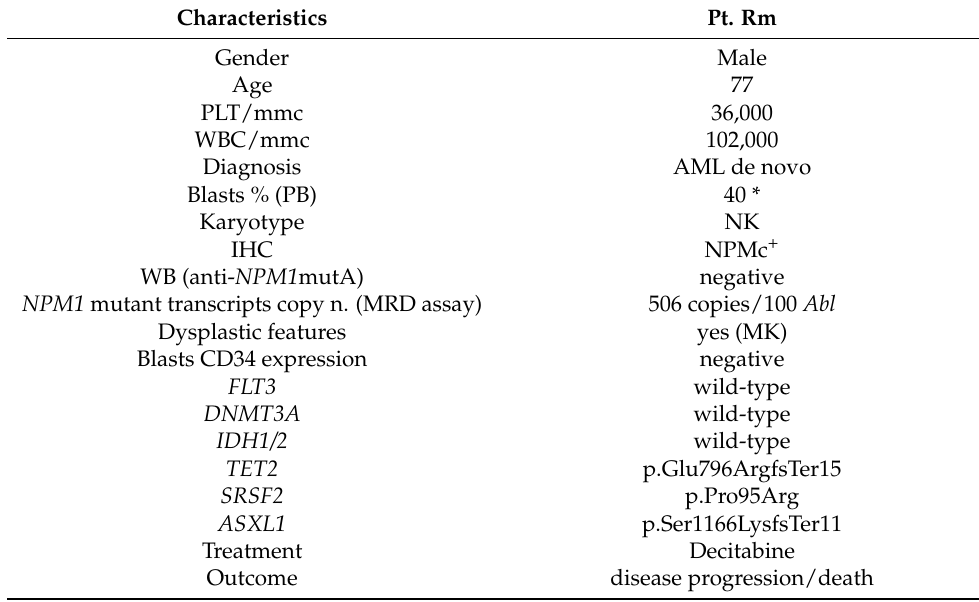
Table 1. Biological and clinical features of AML patient with NPM1 mutation Rm.